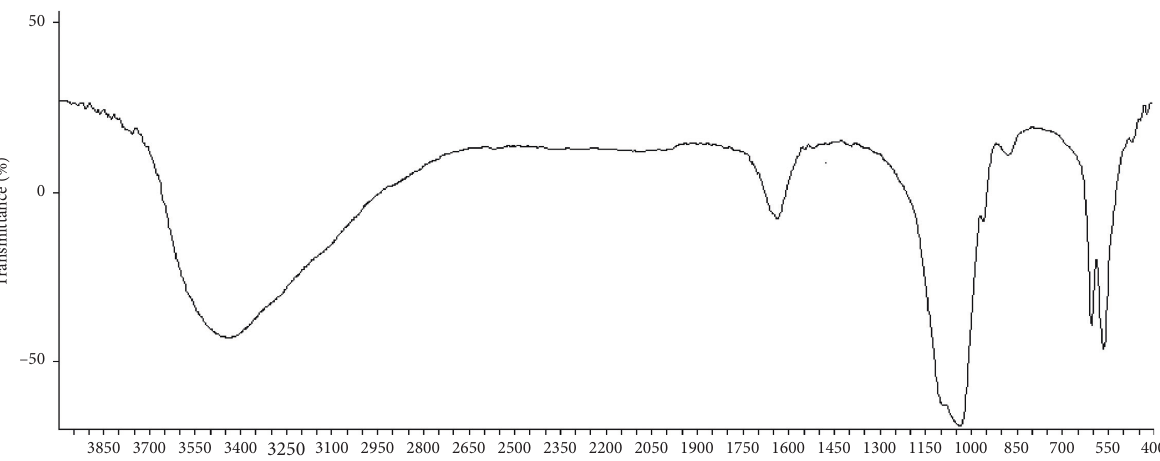
Figure 5: Infrared spectrum of the obtained precipitate under optimum